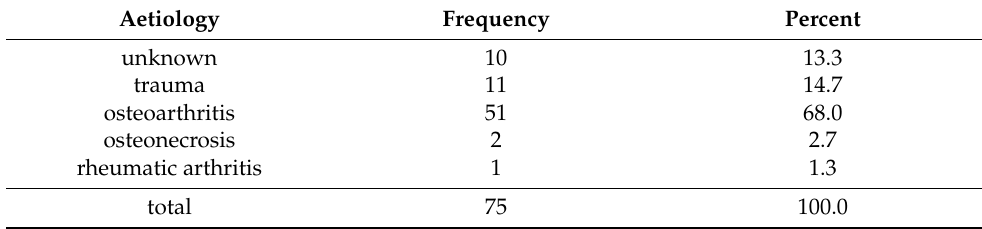
Table 2. Reasons for first